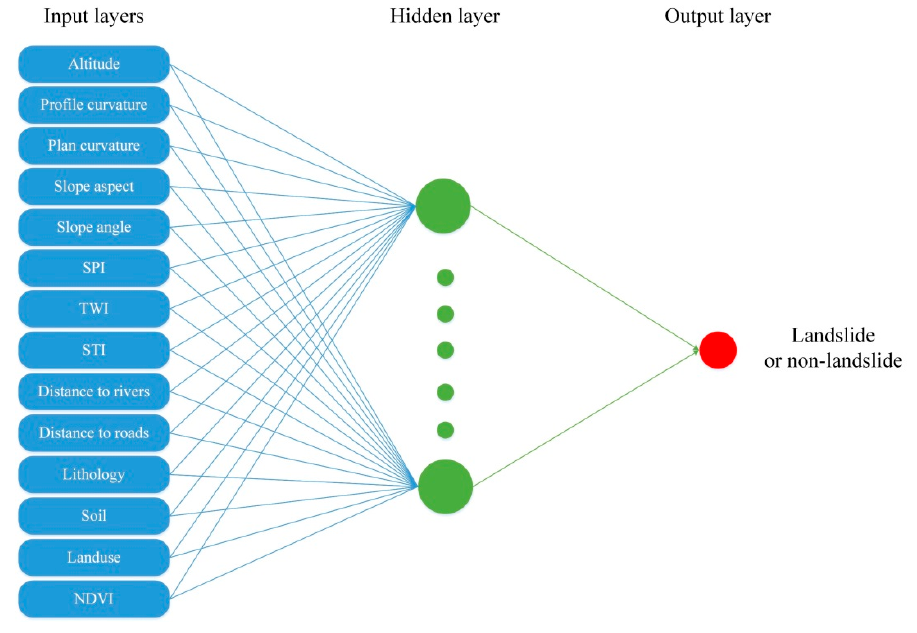
Figure 6. Histogram of landslide susceptibility classes.